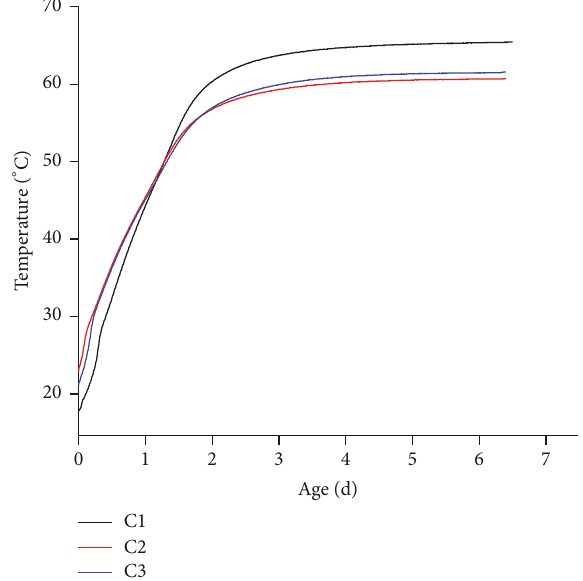
Figure 4: Adiabatic temperature rise curves of plain cement con- crete and concretes containing 50% composite mineral